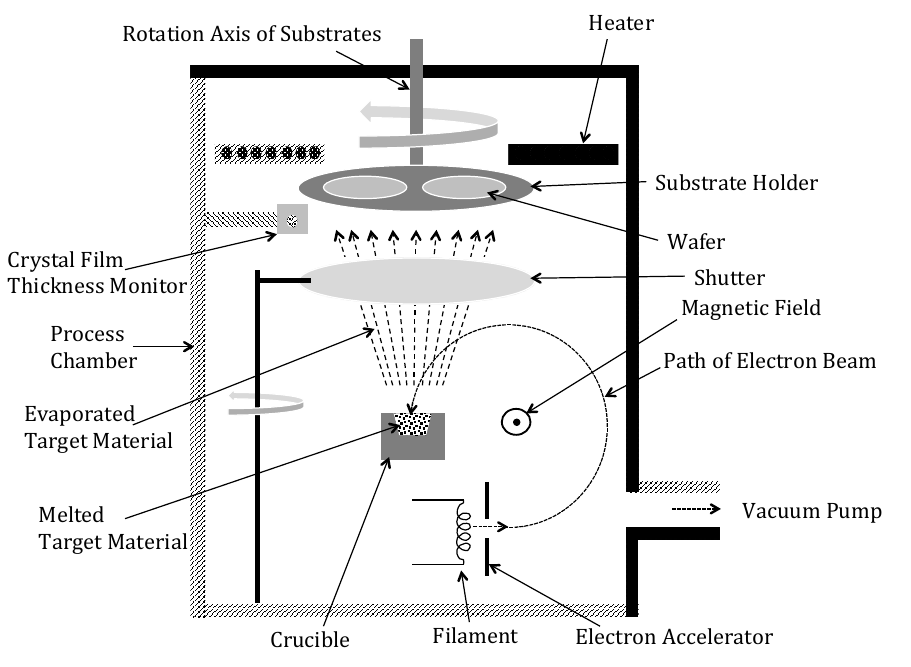
Figure A5. Evaporation tool